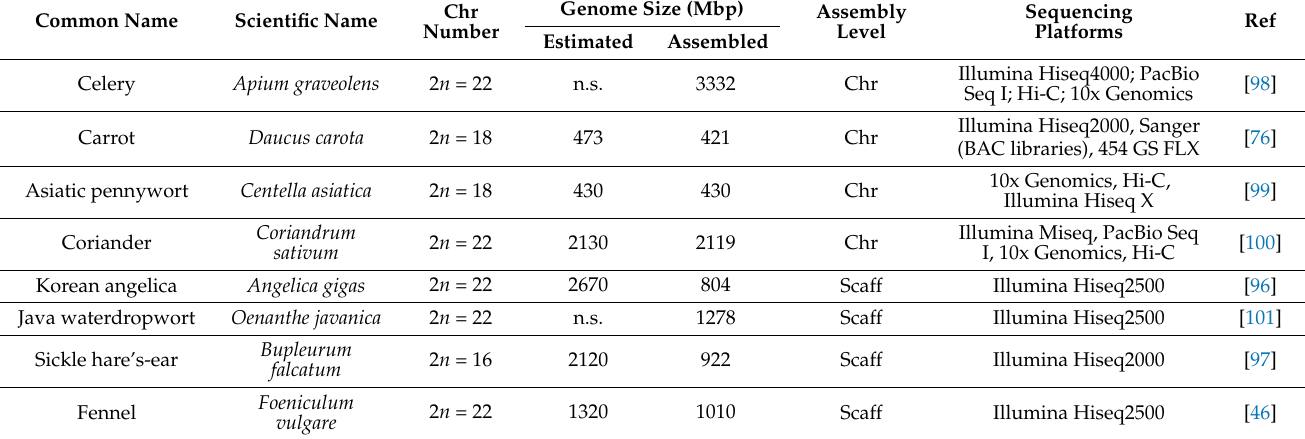
Table 3. Genome assemblies are available for the Apiaceae family, along with the common and scientific name, chromosome (Chr) number, estimated and assembled genome size, level of assembly (chromosome, Chr or Scaffold, Scaff), sequencing platform used and reference. Genomes publicly available are underlined. (n.s. = not